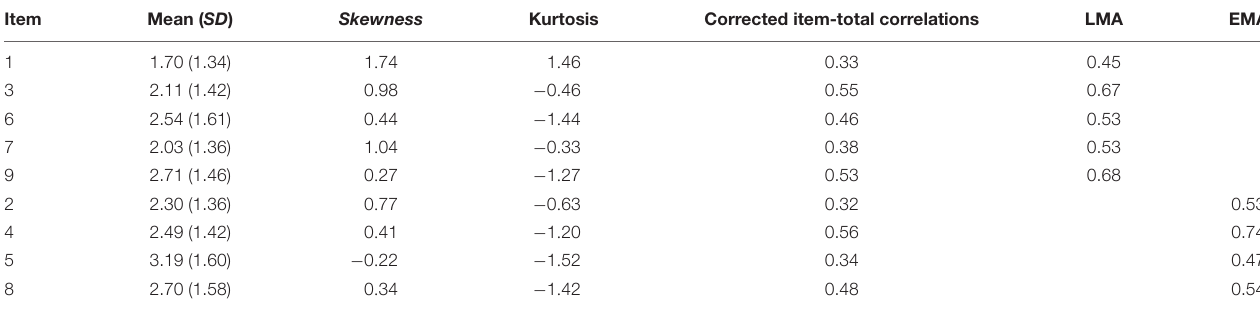
TABLE 2 | Means, standard deviations (SDs), skewness, kurtosis, and item- total correlations for each item, and factor loadings of the EES-AMAS. Item